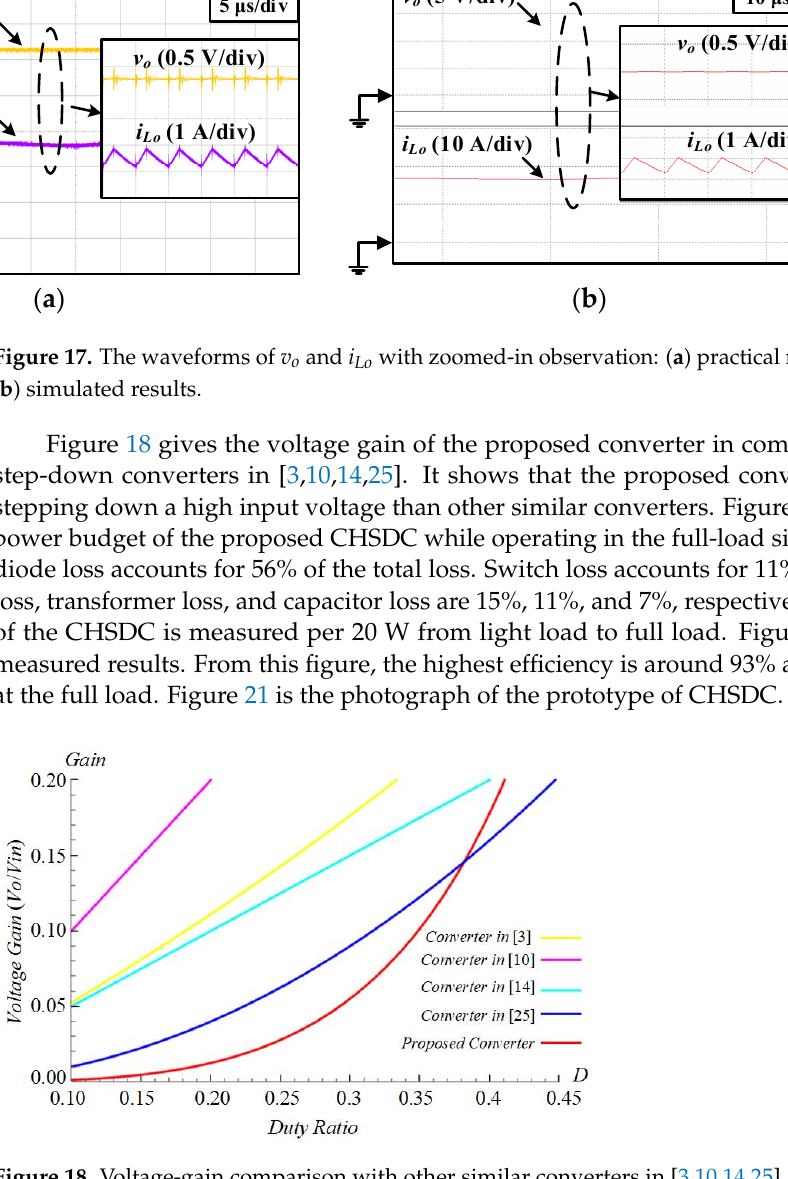
Figure 19. Power budget of the CHSDC. Figure 20. Measured efficiency of the CHSDC from light load to full load. SW